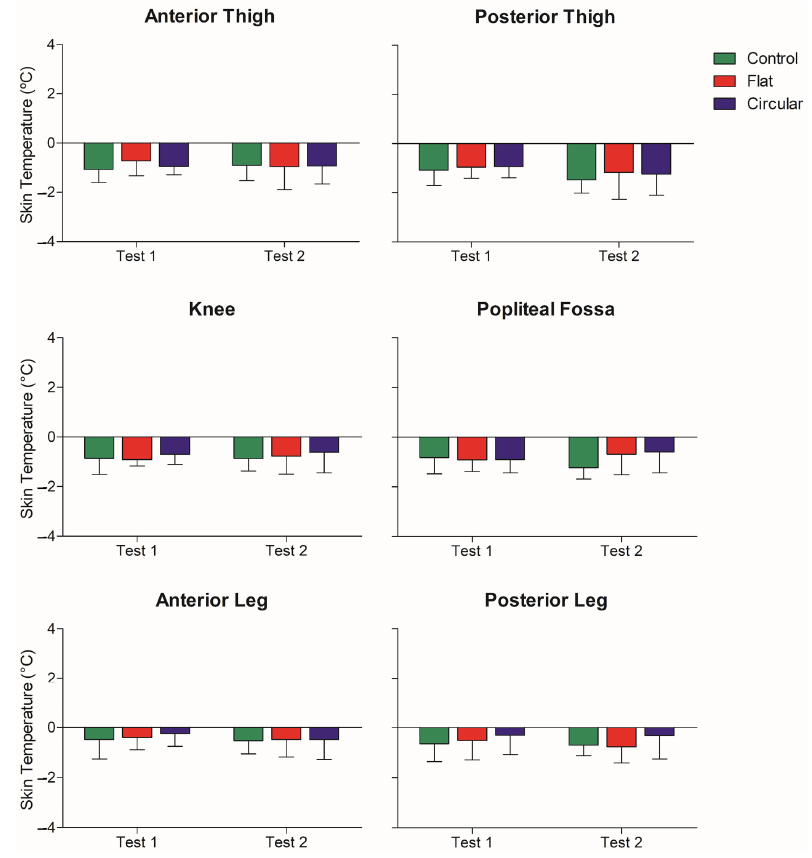
Figure 5. Skin temperature variation (Mean ± SD) for each region of interest in all groups.